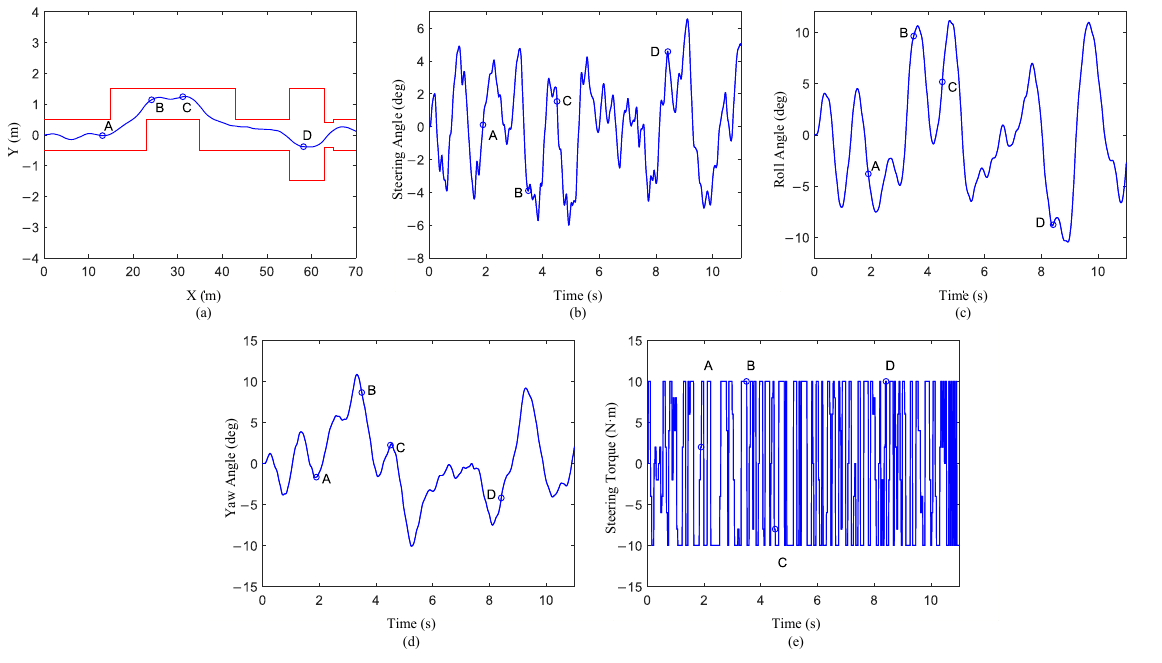
Figure 8. Results of STTW robot driving on narrow terrain: ( a ) front wheel trajectory; ( b ) steering angle; ( c ) roll angle; ( d ) yaw angle; ( e ) steering torque.